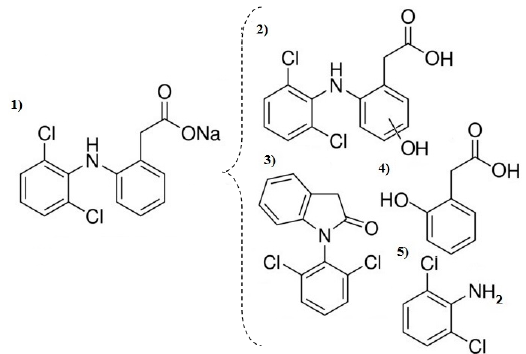
Figure 5. Identified 1 benzocaine by-product, where 2 is ethyl 4-hydroxybenzoate.